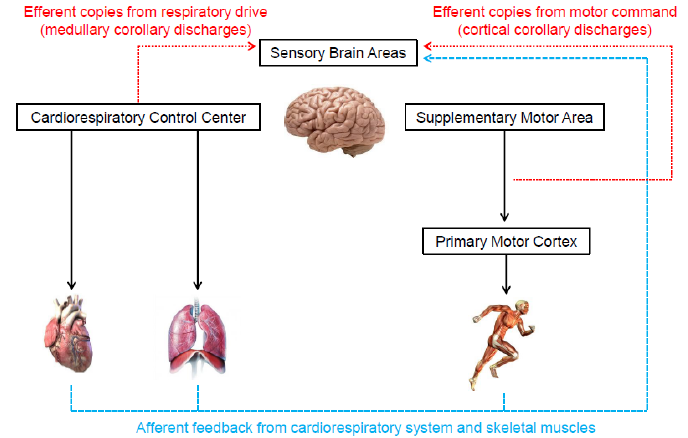
Figure 3. Illustration of the neurophysiological mechanisms underlying the genesis of perceived exertion during exercise.